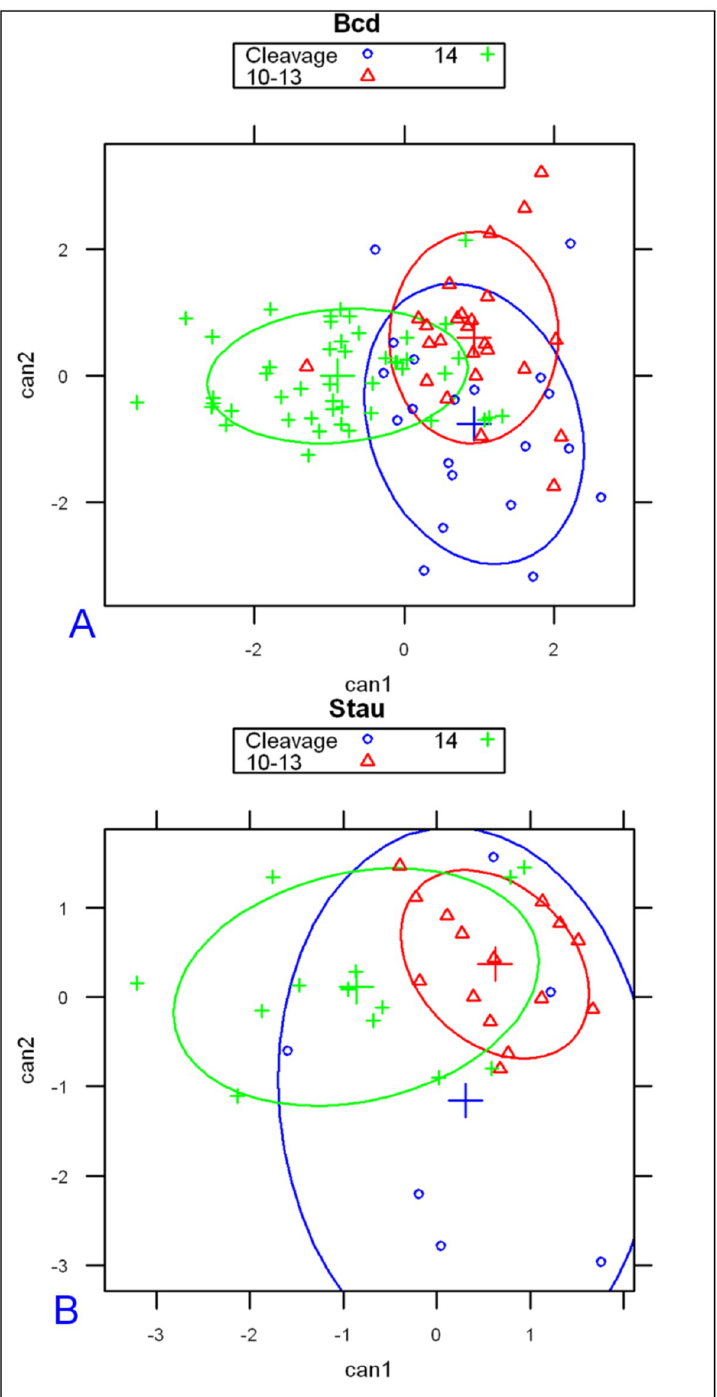
Fig 3. Linear discriminant analysis on model parameters from bcd mRNA (A) and Stau (B) profiles correctly predicts developmental stage for the majority of embryos.